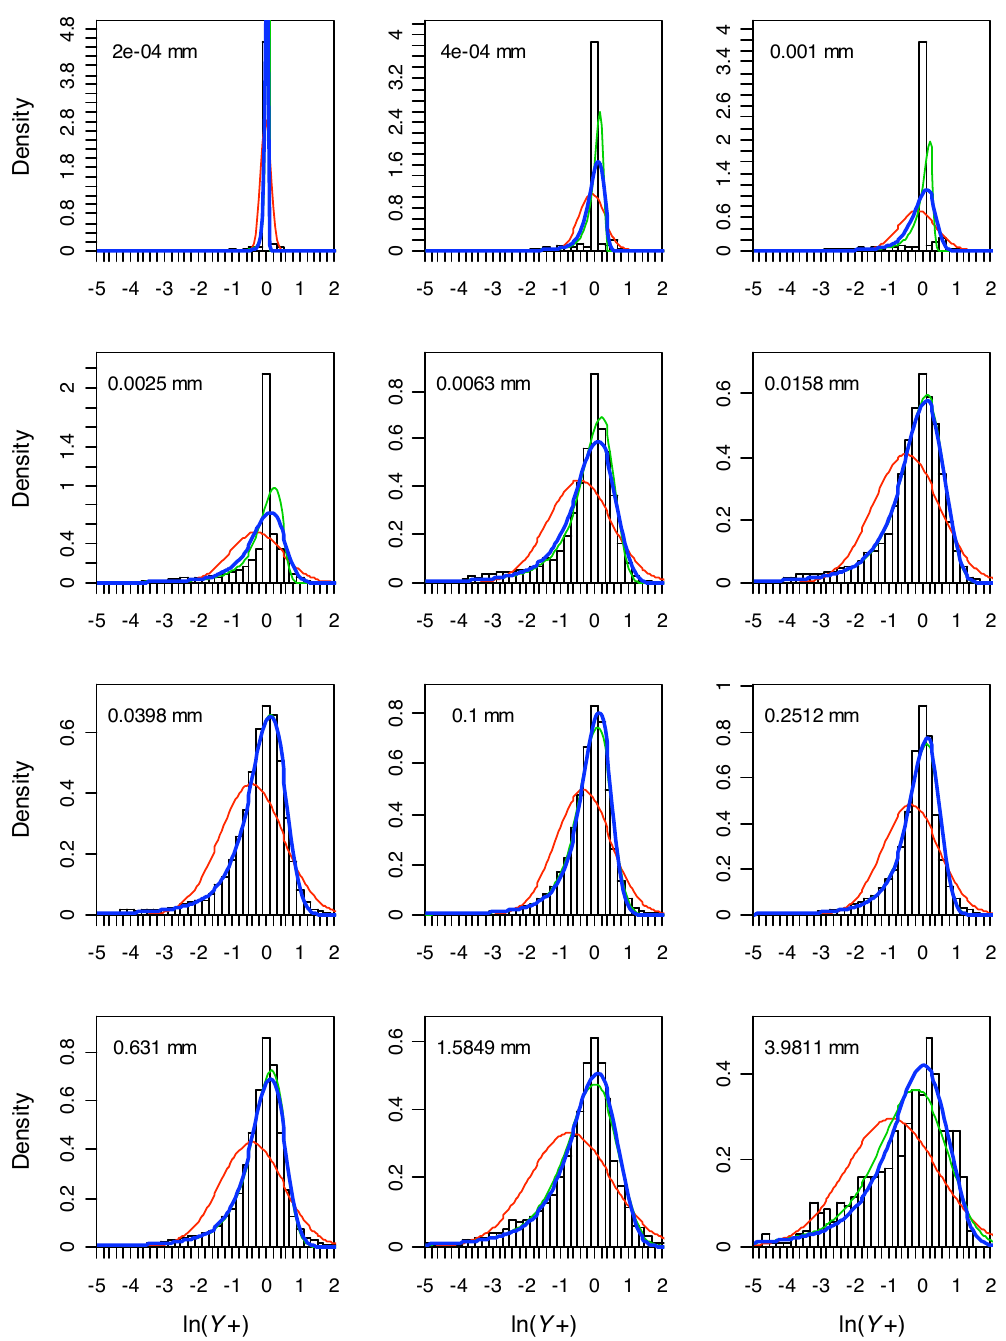
Fig. 4. Empirical density (bars) of ln Y + and densities of the fitted stable distribution with α Z as a fitting parameter (thin green line), with α Z fixed at 1.47 (heavy blue line) and with α Z fixed at 2 (thin red line). Distributions are shown for various large-scale areal-averaged rainfall rates R 0 (as mm per 15-min) for R 0 > 0. The rainfall value shown in each plot is the midpoint of the range of log-transformed rainfall used to bin that data in a given rainfall rate